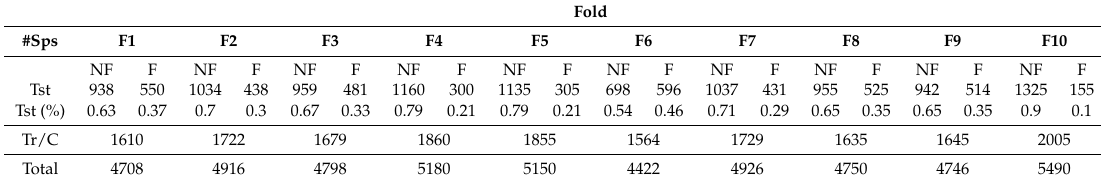
Table 2. The final distribution of train and test data across all folds. As it is easy to observe the NF class dominates F in all testing cases making detection of fatigue much more challenging and highlighting the overall difficulty of the target problem. The abbreviations of Table 2 are the following: Sps: Smaples, Tst: Test, Tr: Train, C: Class. Fold